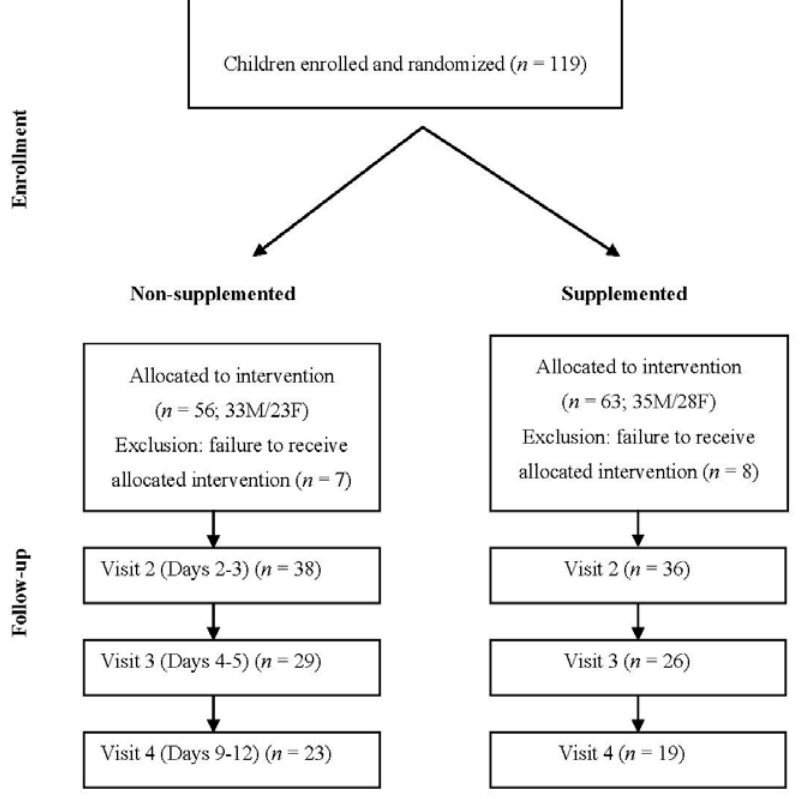
Figure 1. Study flow-sheet: subjects' characteristics and distribution at the follow–up visits.